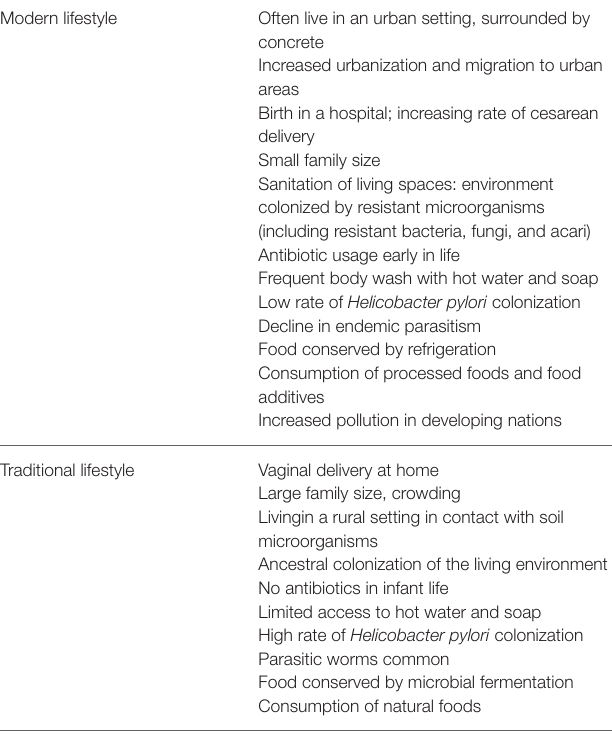
TABLE 2 | Factors associated with modern lifestyle that is potentially associated with alterations of the gut microbiota. Modern